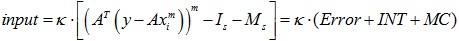
Evolution of approximation for purple-highlighted elements in Fig. 2B, using DG-IST with d = opt = 171 (left panel) and DG-IST with d = inf (right panel).First row of each panel shows the approximation evolution of the two elements, black horizontal lines declare the original elements to be approximated and vertical pink lines (only left panel) show the iterations at which elimination of inhibition takes place for the second largest element in the corresponding column of xm. The second row of each panel illustrates the Input to each GC through the iterative process, input=κ⋅[(AT(y−Axim))m−Is−Ms]=κ⋅(Error+INT+MC). The Error, MC, and INT values that add up to form the Input value are shown in the remaining rows of each panel.